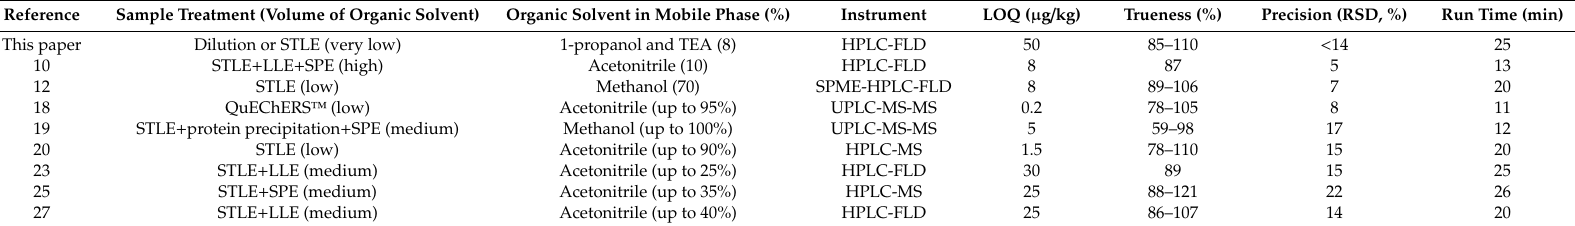
Table 5. Practical and analytical performances of previously published